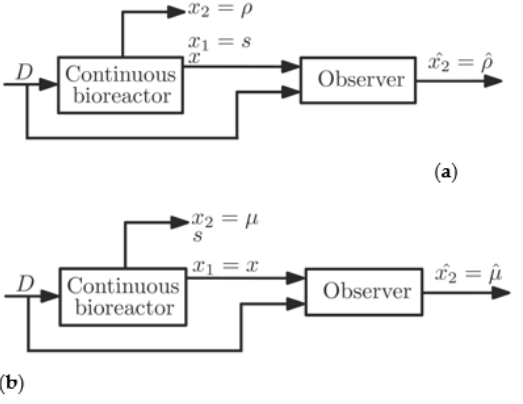
Figure 2. Structures of the observer applications to bioreactor: ( a ) first simulation example; ( b ) second simulation example. 𝑥 is the biomass concentration, 𝑠 is the substrate concentration, 𝜇 is the specific growth rate, 𝜌 is the specific substrate uptake rate, 𝐷 = 𝐹 (cid:3036) /𝑣 is the dilution rate, 𝐹 (cid:3036) is the feeding flow rate, 𝑣 is the broth volume, 𝑥 (cid:2869) is the known state , 𝑥 (cid:2870) is the unknown state, 𝑏 , ℎ (cid:2869) , ℎ (cid:2870) are known terms of plant model (1), (2), and 𝑥(cid:3548) (cid:2870) is the estimate of 𝑥 (cid:2870) .